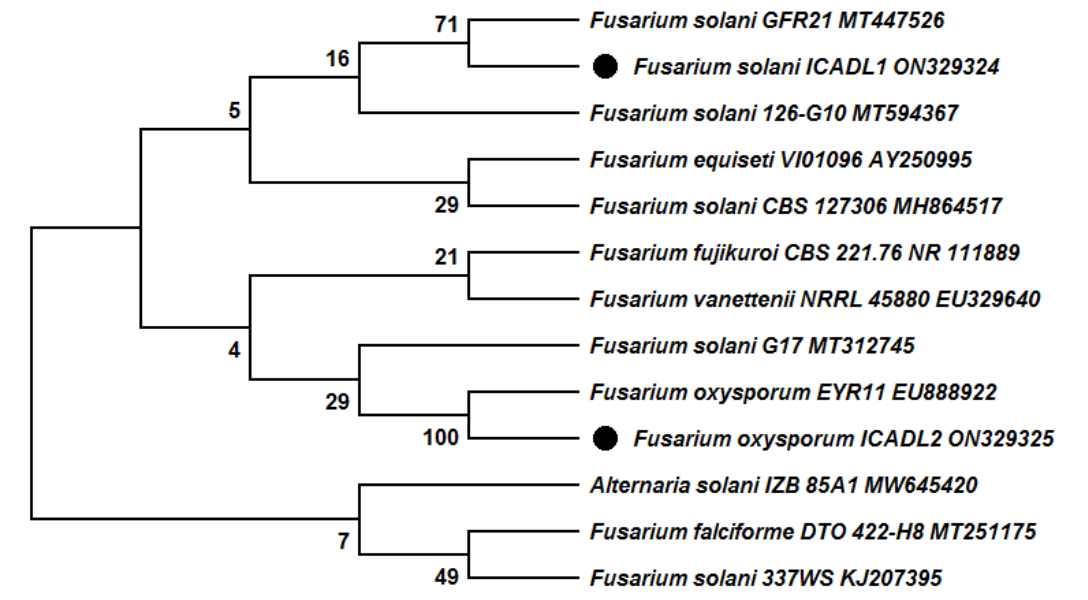
Figure 2. Phylogenetic tree constructed by neighbor-joining method (values at branching points indicate bootstrap) based on ITS sequences showing the relationship of isolated Fusarium strains to closely related species. (bootstrap values expressed as percentages of 1000 replications).